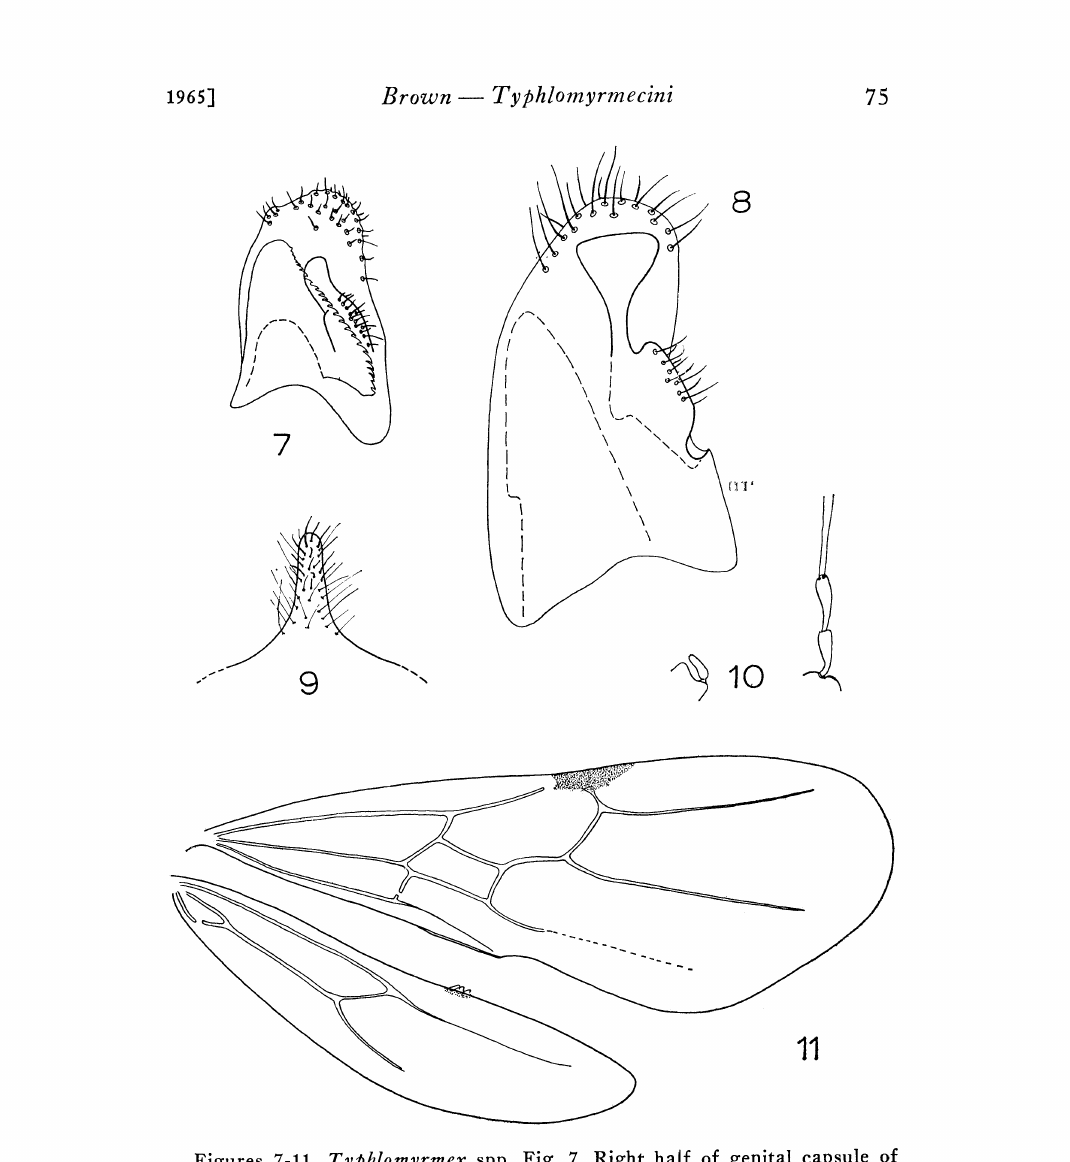
Figures 7-11, Typhlomyrmex spp. Fig. 7, Right half of genital capsule of T. clavicornis male from British Guiana, viewed from inside, ventral side to right, semidiagrammatie. Fig. 8, same., T. rogenhoferi, aedeagal valve omitted. Fig. 9, hypopygial process of T. royenhoferi, ventral view. Fig. 10, maxillary palpus (left) and labial palpus (right) of T. rogenhoferi. Fig. 11, right wing of T. royenhoferi Figs. 8-11 are drawn from a male